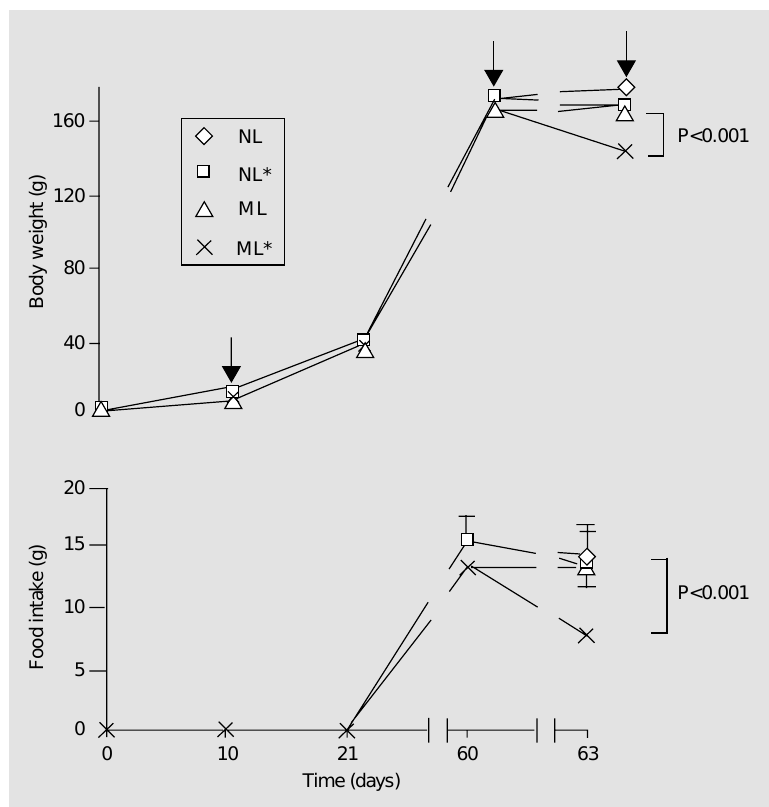
Figure 3. Plasma insulin (A) and leptin concentration (B) of rats from dams normally nourished (NL) or malnourished (ML) with a protein-free diet (PFD) during the first 10 days of lactation. NL10 and ML10 represent the hormone concentration of animals at 10 days of age. NL60 and ML60 rep- resent the animals submitted to the above treatment at 60 days of age and NL63 and ML63 corre- spond to animals that were later fed a PFD during the last 3 days (from 60 to 63 days). *P<0.01 and **P<0.001 compared to control at same age and 3 days after PFD (Student t- test and